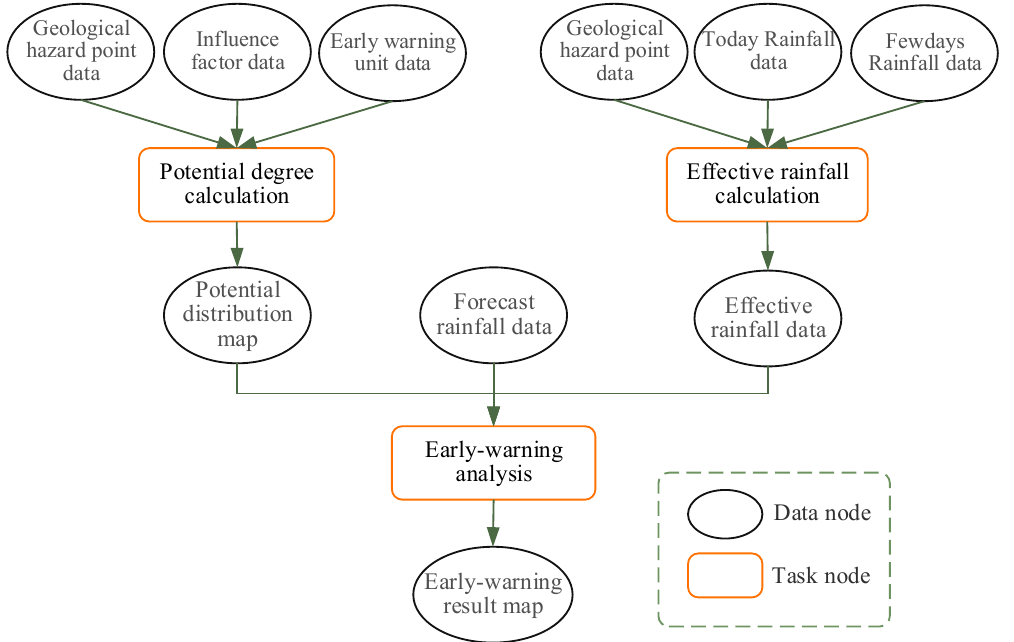
Figure 1. Sequences of the meteorological early-warning (MEW) process.